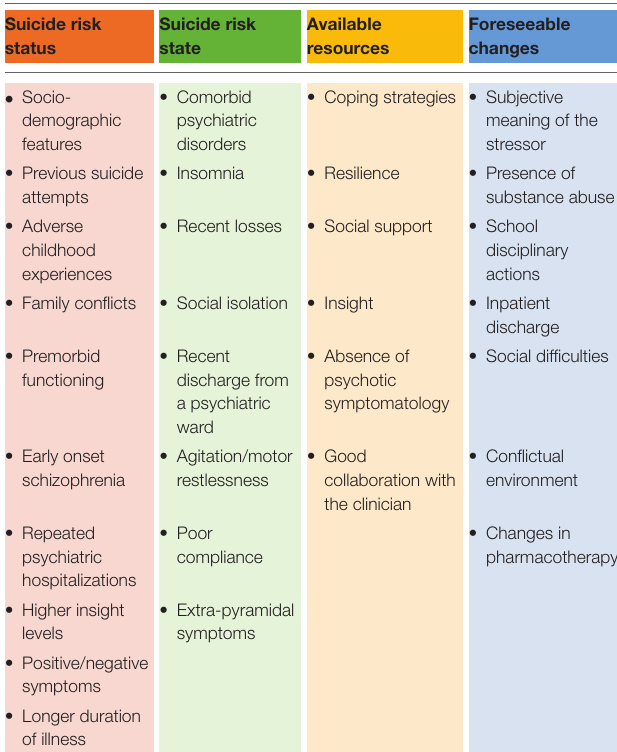
TABLE 1 | Suicide risk formulation in